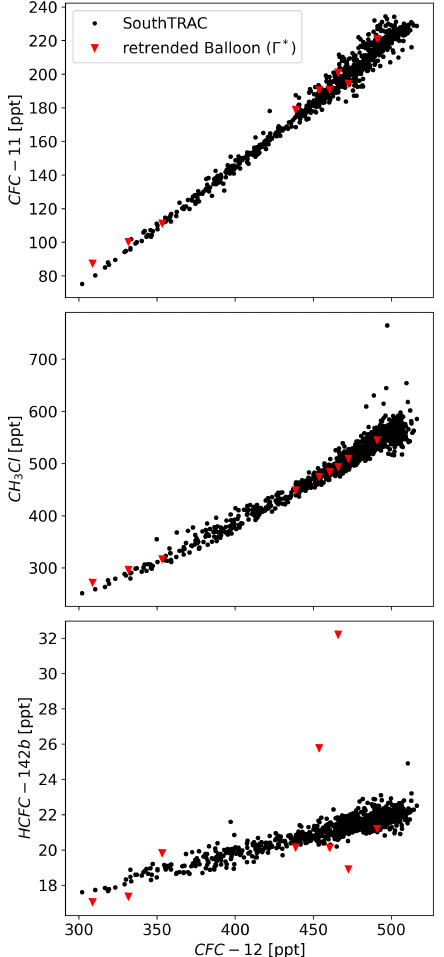
Figure 6. Correlation between CFC-12 and CFC-11, between CFC- 12 and CH 3 Cl, and between CFC-12 and HCFC-142b. The raw measurements by GhOST-MS are shown in black, and the balloon observations scaled to the time of the SouthTRAC campaign using mean arrival time are shown in